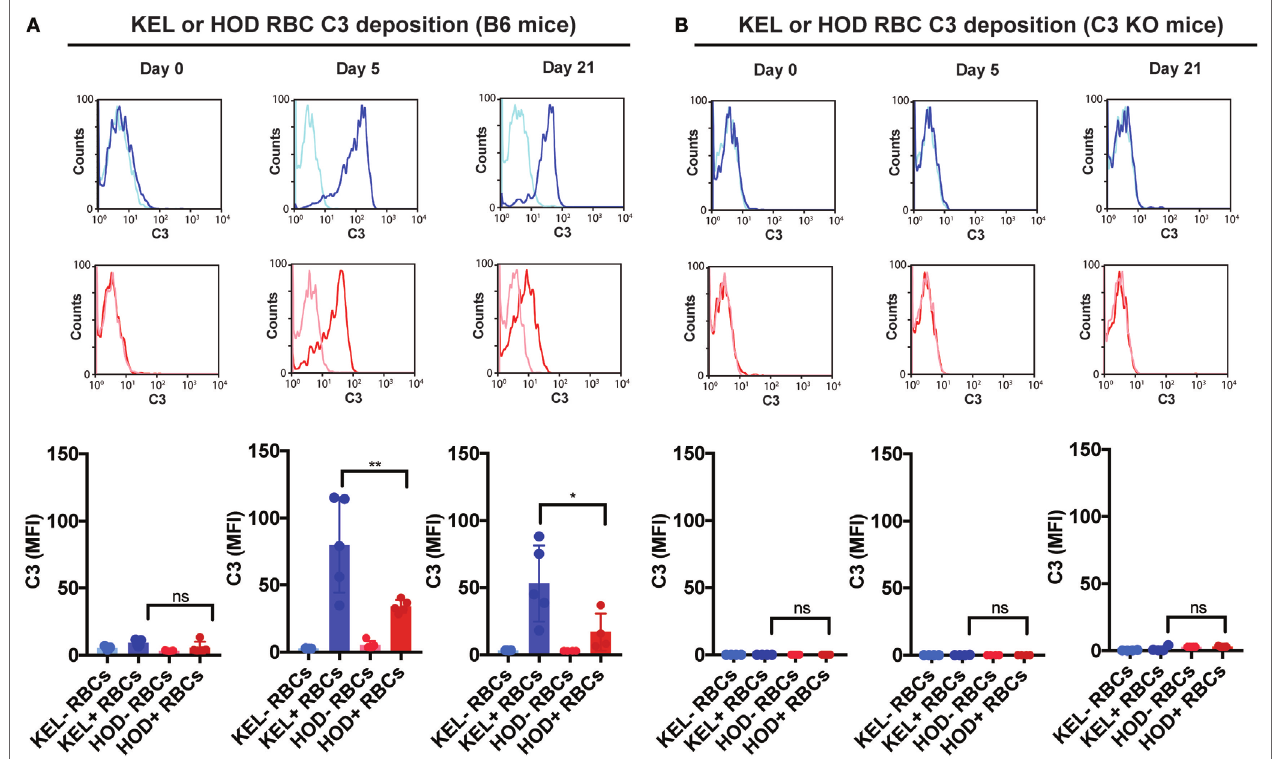
FigUre 3 | KEL red blood cells (RBCs) exhibit increased levels of complement component 3 (C3) deposition when compared to HOD RBCs over time post- transfusion. (a) Total C3 bound to circulating KEL-negative RBCs (KEL − RBCs), KEL-positive RBCs (KEL + RBCs), HOD-negative RBCs (HOD − RBCs) or HOD-positive RBCs (HOD + RBCs) was assessed on days 0, 5, and 21 post-transfusion into B6 mice. (B) Total C3 bound to circulating KEL-negative RBCs (KEL − RBCs), KEL-positive RBCs (KEL + RBCs), HOD-negative RBCs (HOD − RBCs) or HOD-positive RBCs (HOD + RBCs) was assessed on days 0, 5, and 21 post-transfusion into C3 KO mice. (a,B) ** p < 0.005, * p < 0.05 and ns = not significant. Means ± SD